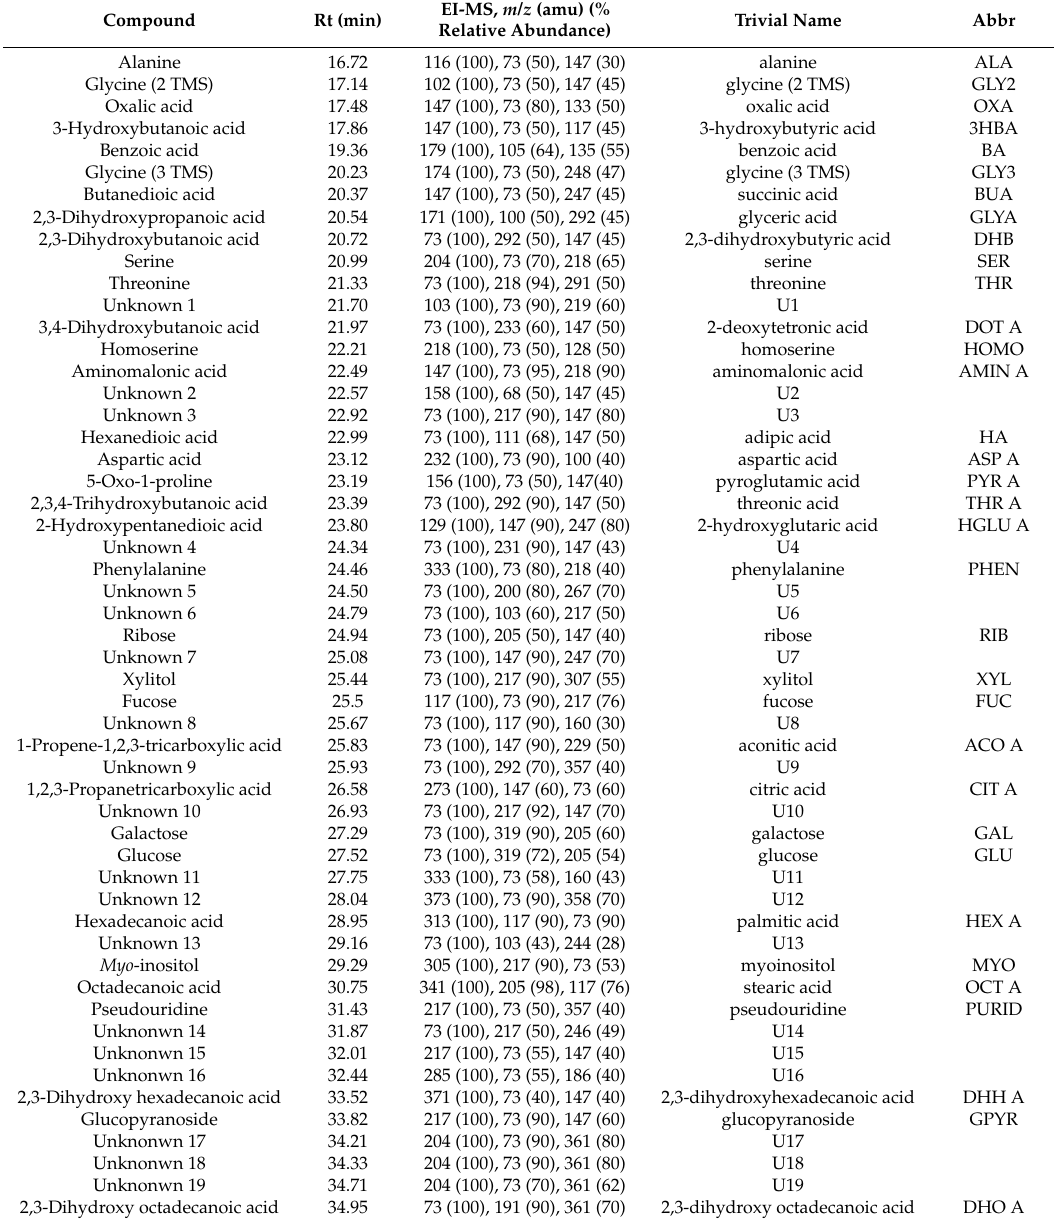
Table 1. Gas-chromatography mass spectrometry (GC-MS) characteristics of urine metabolites.